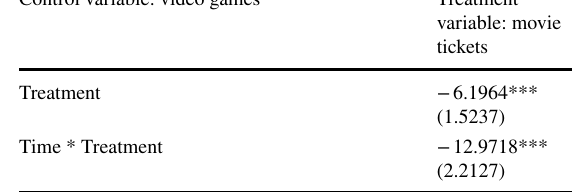
Table 7 Differences-in- differences estimation about alternative leisure options (movie tickets vs. video